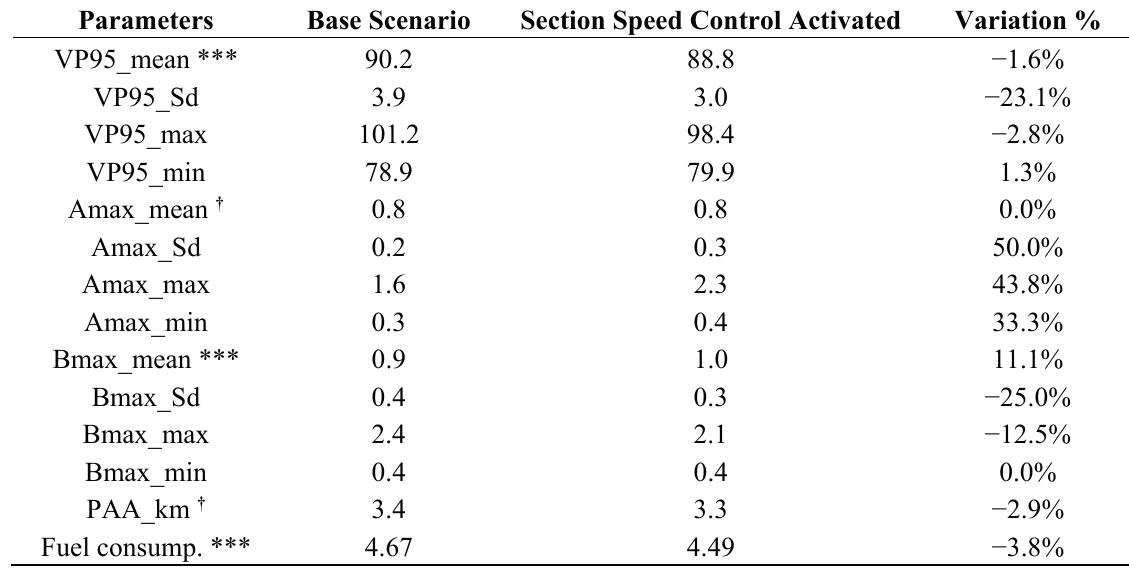
Table 3. Changes in vehicle trajectory variables produced by the activation of a section speed control